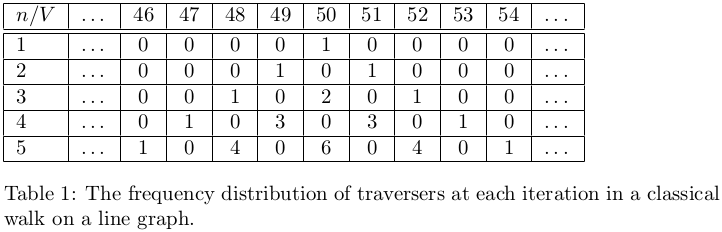
Table from the paper: Quantum Walks with Gremlin
Table text:
n/V
...
46
47
48
49
50
51
52
53
54
...
1
...
0
0
0
0
1
0
0
0
0
...
2
...
0
0
0
1
0
1
0
0
0
...
3
...
0
0
1
0
2
0
1
0
0
...
4
...
0
1
0
3
0
3
0
1
0
...
5
...
1
0
4
0
6
0
4
0
1
...
Table1:Thefrequencydistributionoftraversersateachiterationinaclassical
walkonalinegraph.